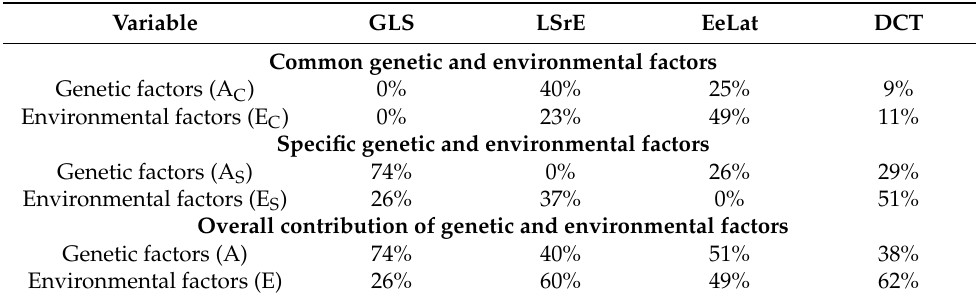
Table 3. Proportion of common and specific genetic and environmental factors contributing to heritability of systolic and diastolic